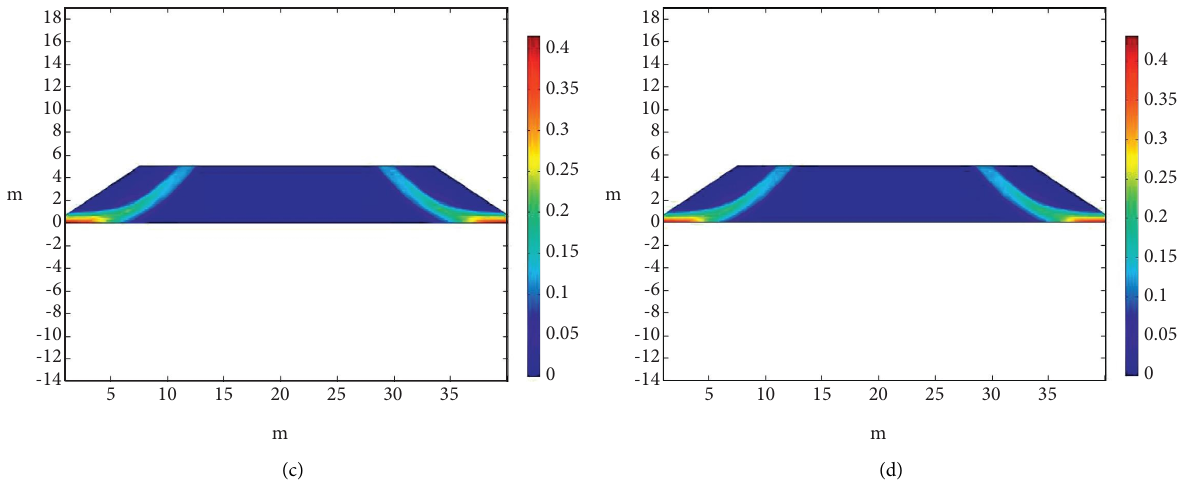
Figure 22: Efective plastic strain diagram of the cross-section at each moment of the unreinforced embankment: (a) d � 1; (b) d � 3; (c) d � 5; (d) d �